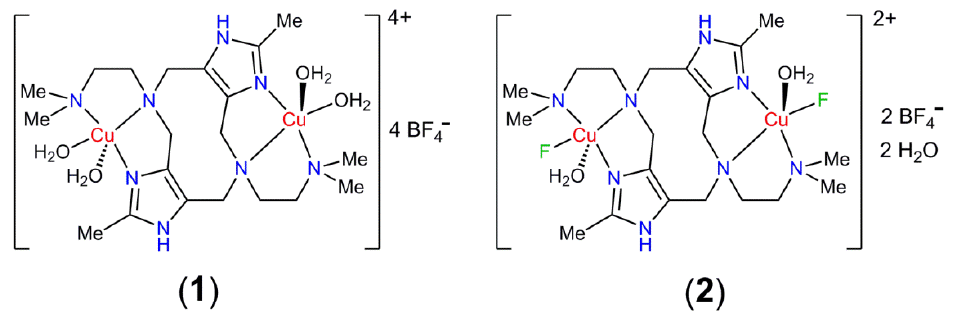
Figure 1. Complexes 1 and 2 characterized by X-ray